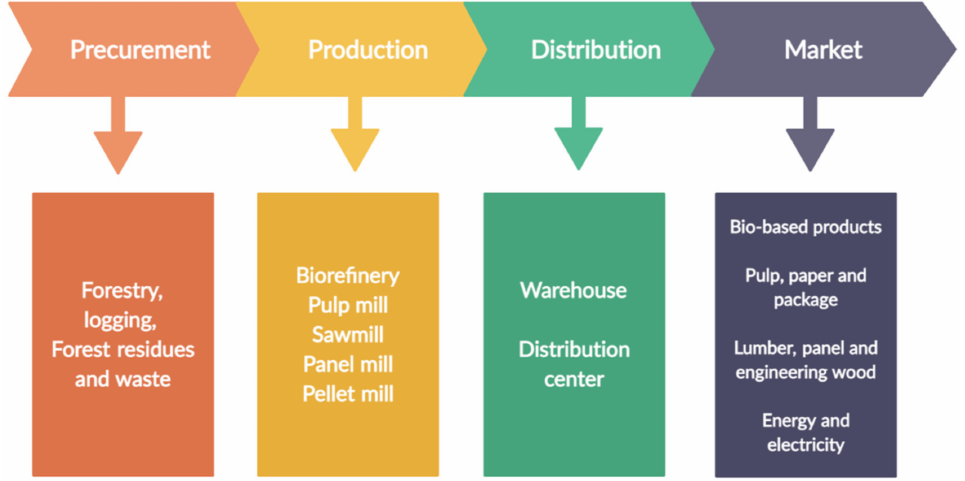
Figure 1. The processes of the forest supply chain, adapted from